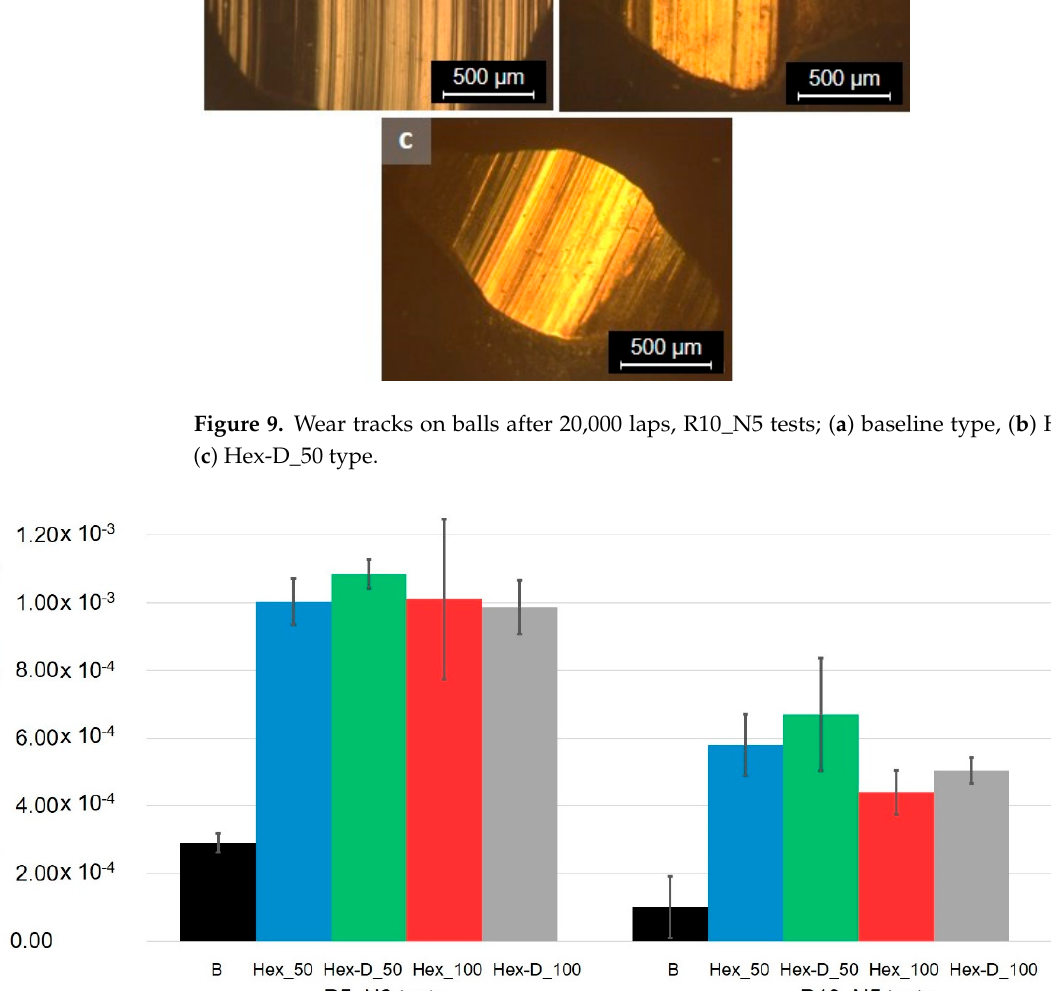
Figure 10. Specific wear rate from tribological tests after 20,000 laps.